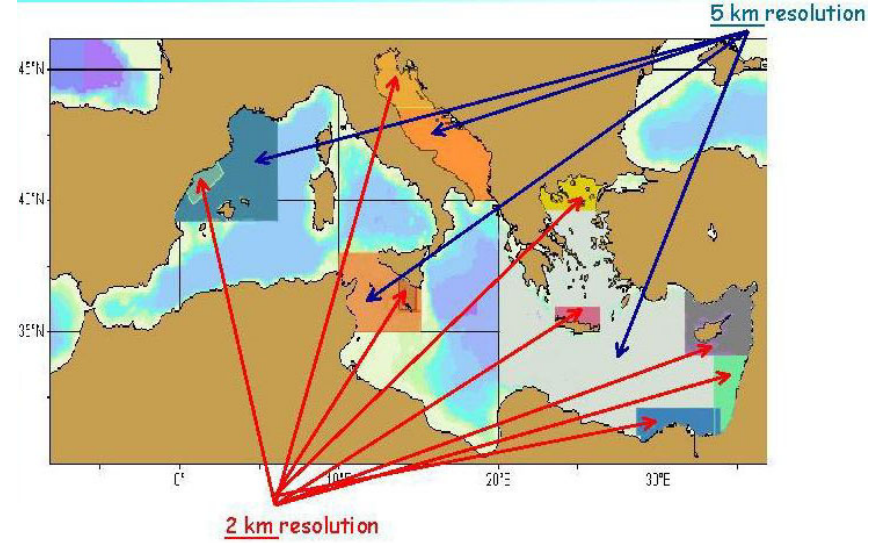
Fig. 1. High resolution simulations in the Mediterranean Sea with nested model and implementations: regional and shelf models of the MFSPP project.